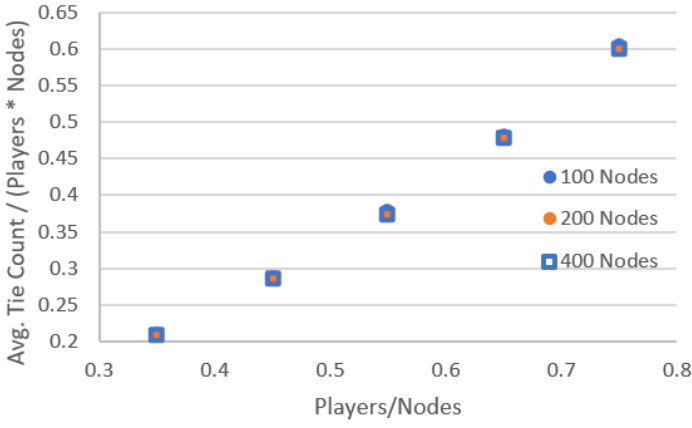
Figure 8. Normalized average tie counts in different RPS configurations.